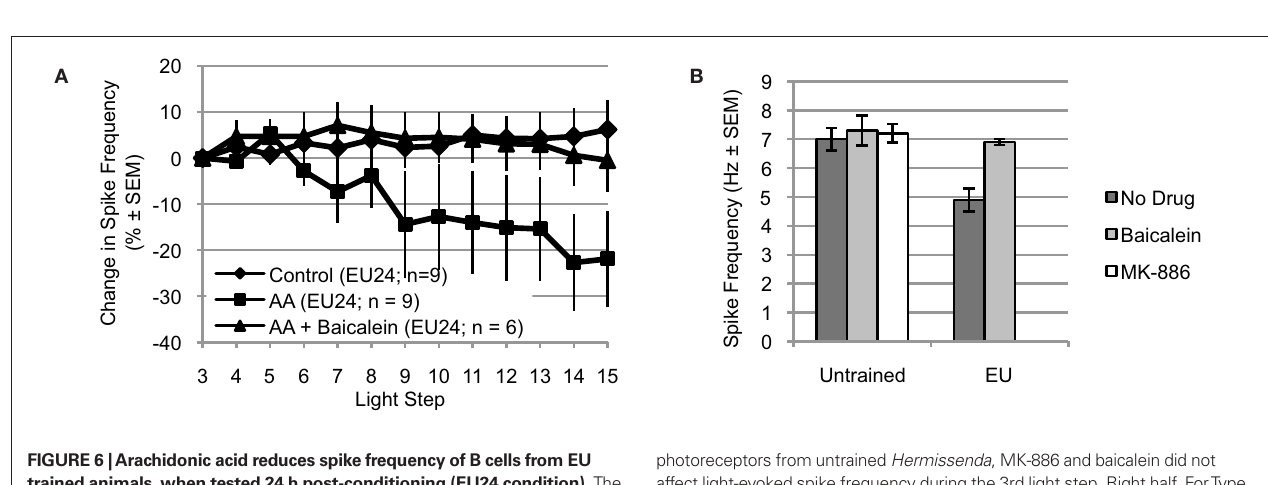
an occlusion effect by EU conditioning. (B) The mean light-evoked spike frequency in B cells from EU0 Hermissenda fell between that of untrained and EU24 Hermissenda ; however, it was not significantly different from either one.